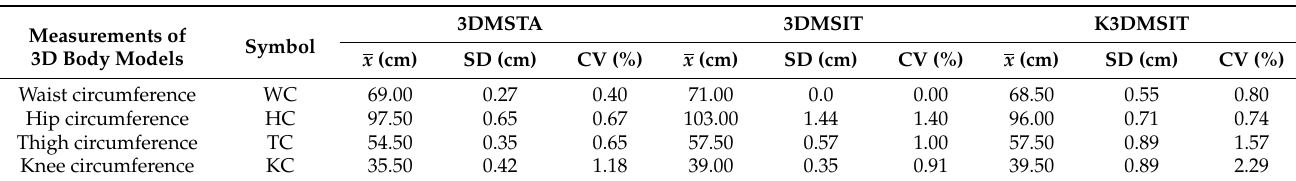
Table 8. Three-dimensional body measurements of standing (3DMSTA), sitting (3DMSIT) and kinematic sitting (K3DMSIT) postures.